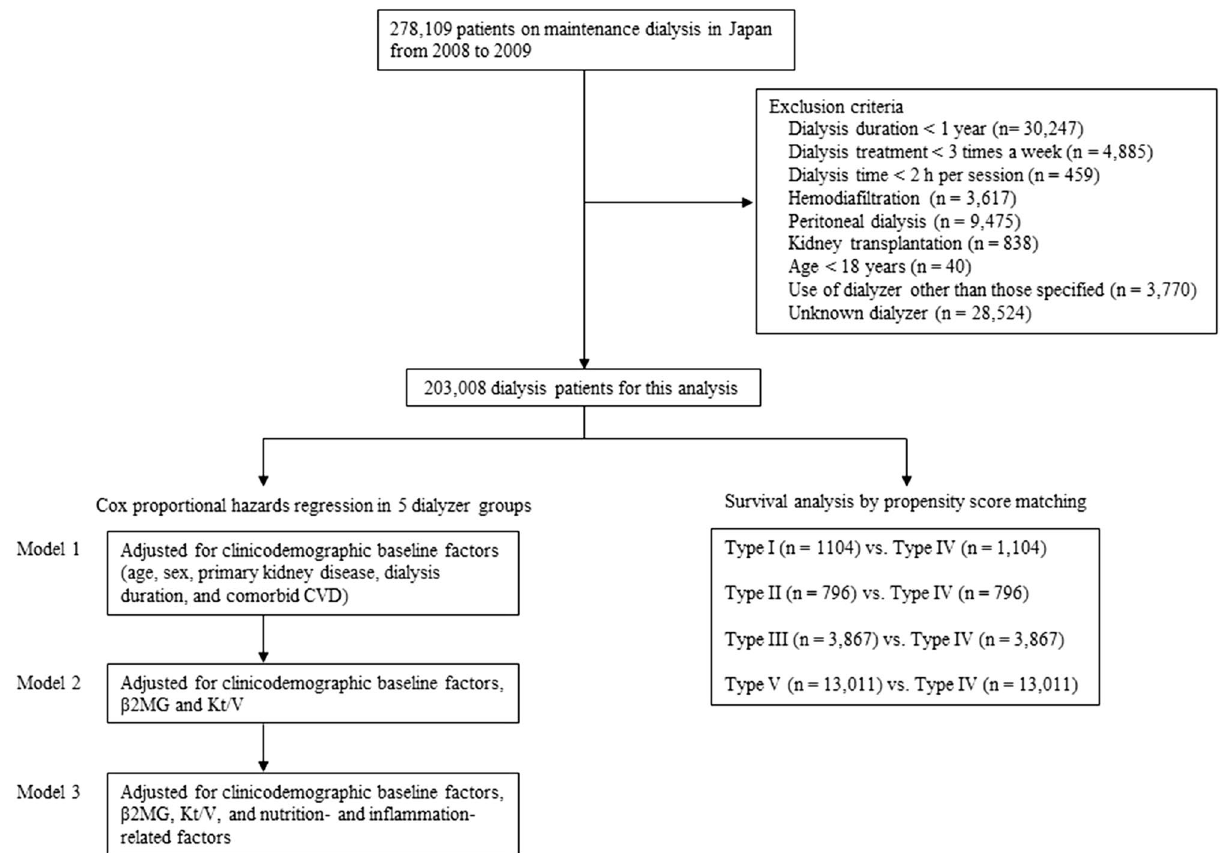
Figure 1. Flowchart of study participants. β2MG β2-microglobulin, CVD cardiovascular